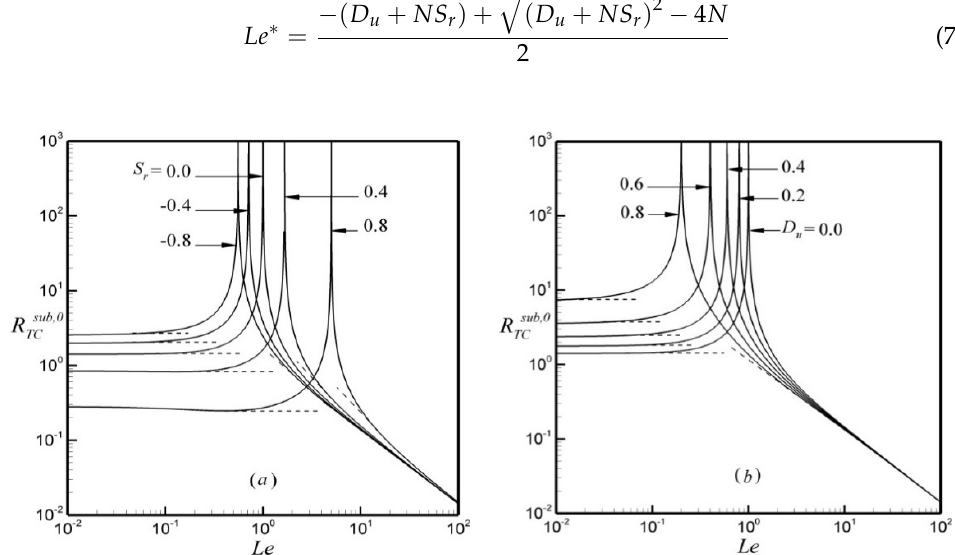
Figure 10. Subcritical Rayleigh number R sub ,0 as a function of the Lewis number, Le , and various values of ( a ) S r ( D u = 0) and ( b ) D u ( S r =